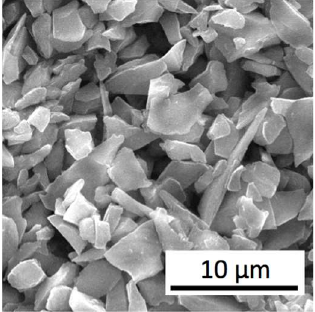
Figure 3. SEM image of α–Al 2 O 3 nanopowder.